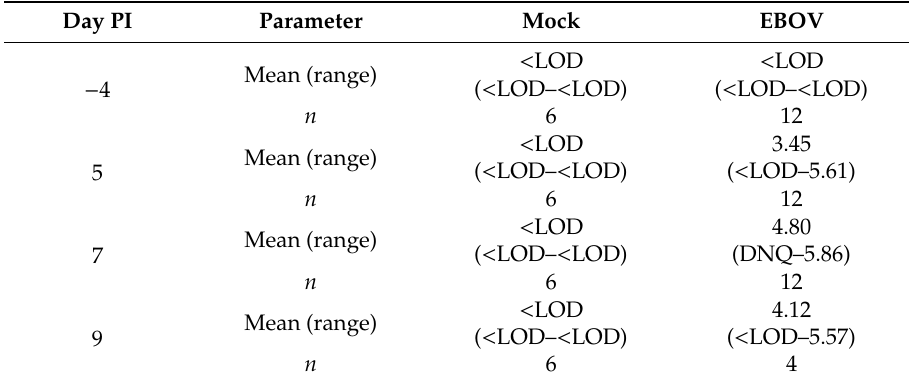
Table 1. Serum infectious virus (log 10 pfu / mL).